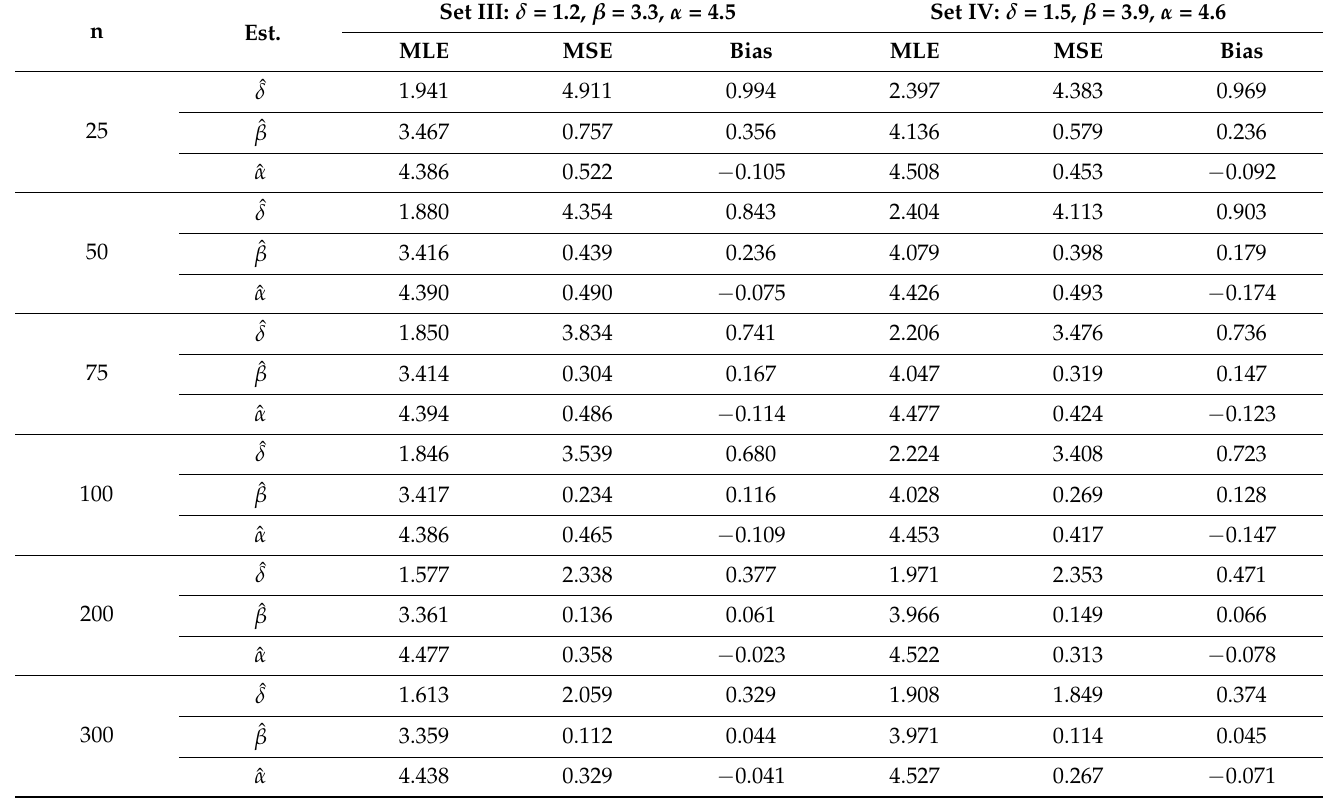
Table 3. SRs of the NGLog–Weib distribution for Set III and Set